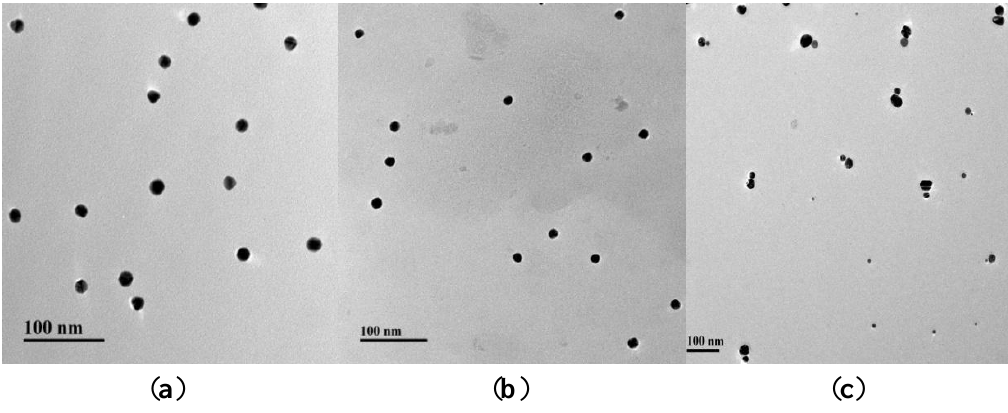
Figure 2. Representative TEM images of AgNPs: ( a ) dispersed single 20 nm AgNPs; ( b ) dispersed single 10 nm AgNPs; and ( c ) a symmetric AgNP